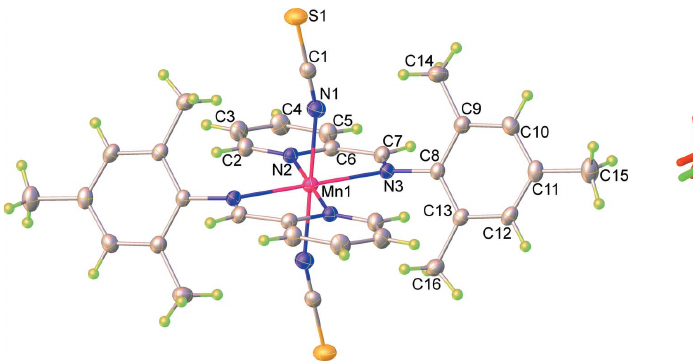
Figure 1 Molecular structures of the title complex ( I ), showing the atom-labelling scheme. Displacement ellipsoids are drawn at the 50% probability